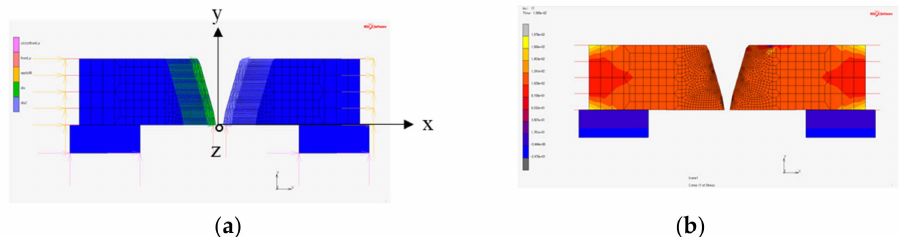
Figure 10. Analysis of restraint degree for the thickness of 70 mm: ( a ) forced displacement, 1 mm, and ( b ) stress distribution by forced displacement.